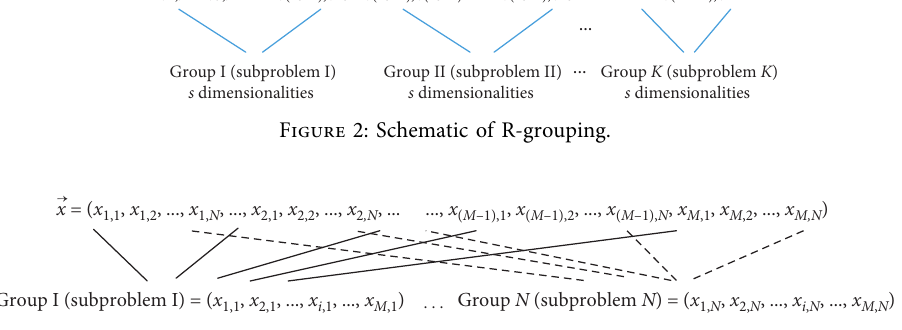
Figure 3: Schematic of CU-grouping.